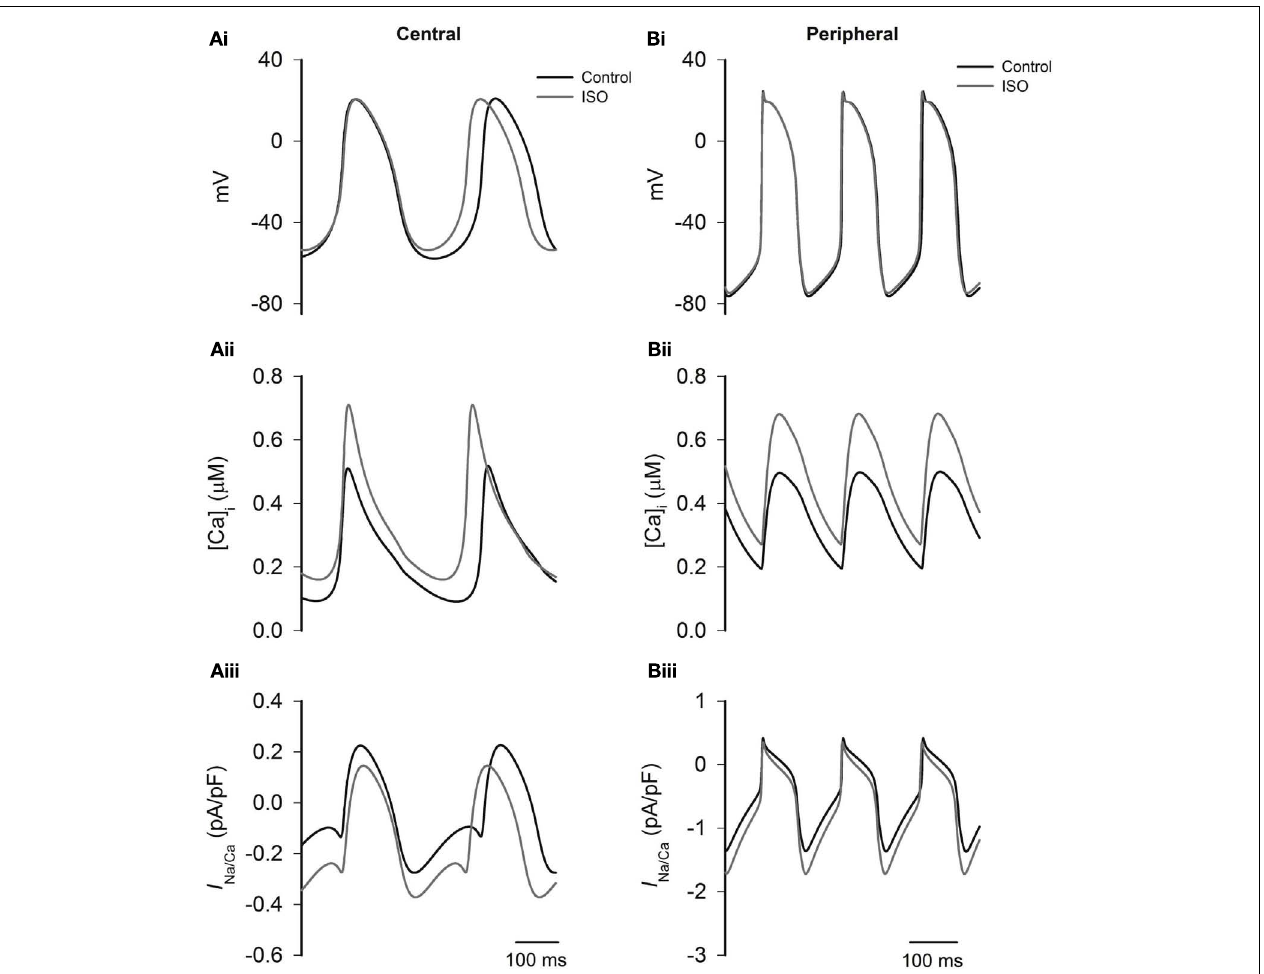
conditions and in the presence of ISO. In ISO simulations, all effects except modulation of the intracellular Ca 2 + transient are omitted.The simulations show that the increase in the Ca 2 + transient plays an important role in response of the central cell model to